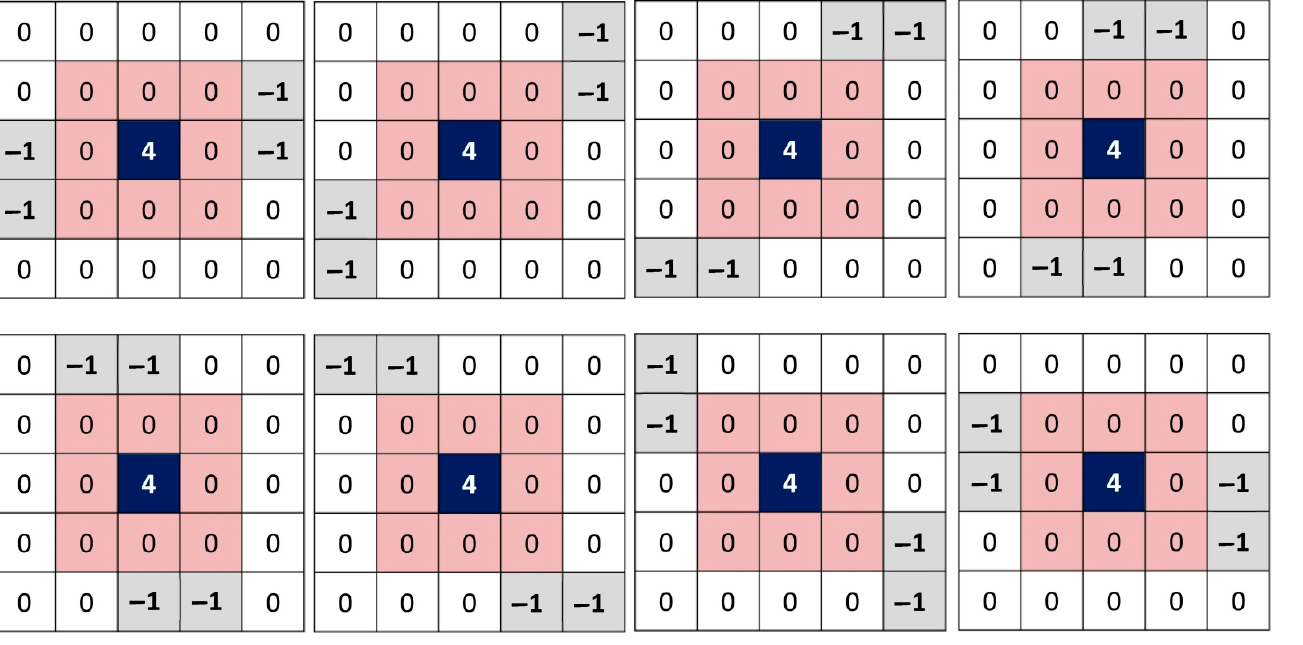
Figure 4. Eight new kernels proposed without taking into account the eight direct neighbors, K 9 to K 16